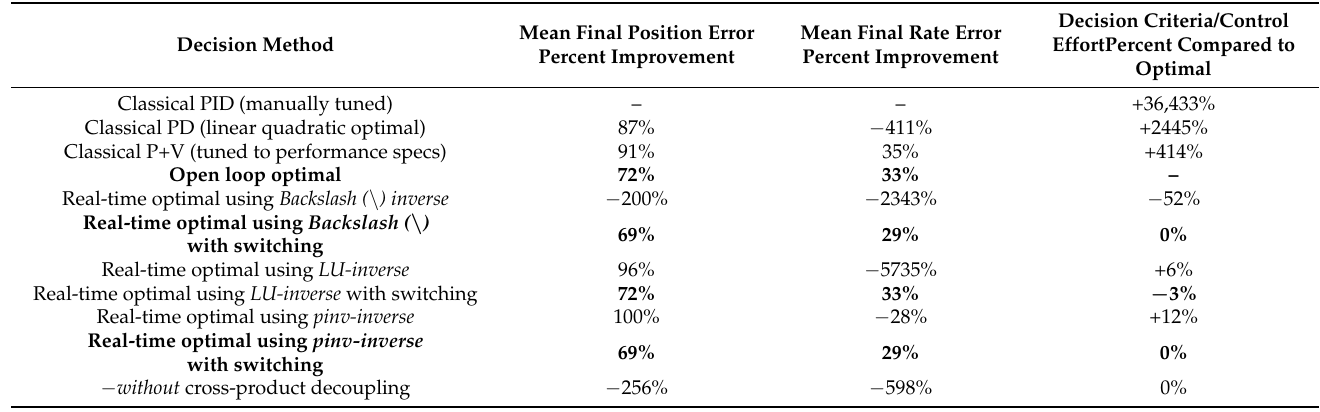
Table 11. Percent improvement comparison of real-time optimal decision methods percent performance improvement. Decision